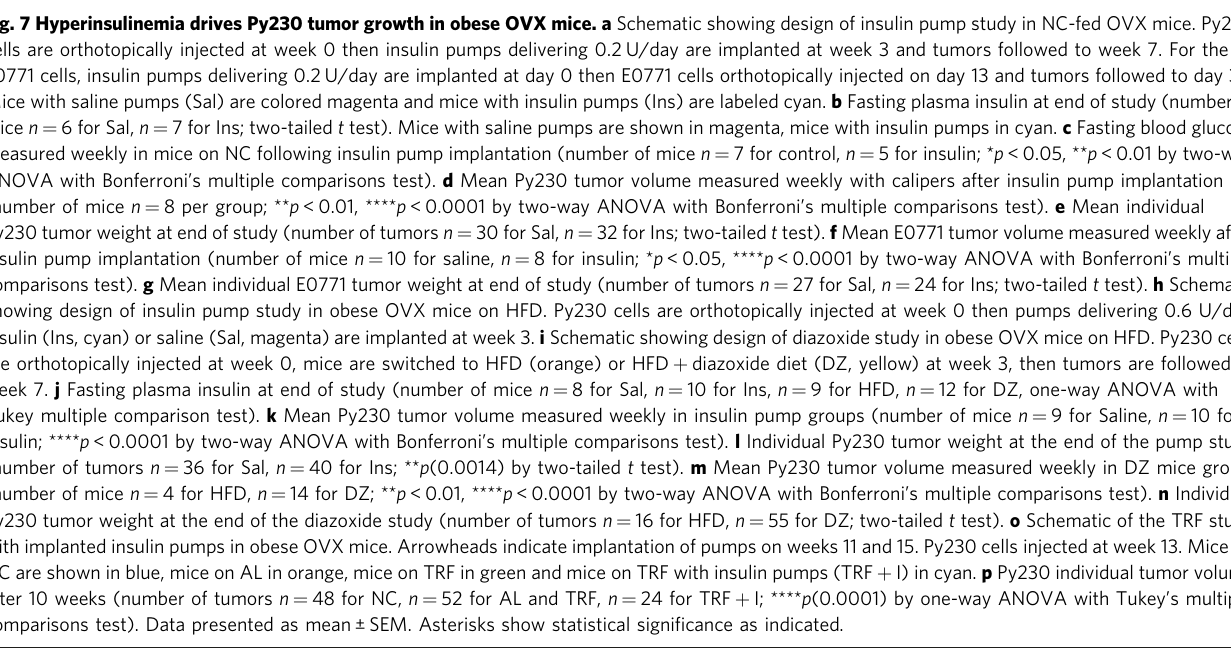
Fig. 7 Hyperinsulinemia drives Py230 tumor growth in obese OVX mice. a Schematic showing design of insulin pump study in NC-fed OVX mice. Py230 cells are orthotopically injected at week 0 then insulin pumps delivering 0.2 U/day are implanted at week 3 and tumors followed to week 7. For the E0771 cells, insulin pumps delivering 0.2 U/day are implanted at day 0 then E0771 cells orthotopically injected on day 13 and tumors followed to day 35. Mice with saline pumps (Sal) are colored magenta and mice with insulin pumps (Ins) are labeled cyan. b Fasting plasma insulin at end of study (number of mice n = 6 for Sal, n = 7 for Ins; two-tailed t test). Mice with saline pumps are shown in magenta, mice with insulin pumps in cyan. c Fasting blood glucose measured weekly in mice on NC following insulin pump implantation (number of mice n = 7 for control, n = 5 for insulin; * p < 0.05, ** p < 0.01 by two-way ANOVA with Bonferroni ’ s multiple comparisons test). d Mean Py230 tumor volume measured weekly with calipers after insulin pump implantation (number of mice n = 8 per group; ** p < 0.01, **** p < 0.0001 by two-way ANOVA with Bonferroni ’ s multiple comparisons test). e Mean individual Py230 tumor weight at end of study (number of tumors n = 30 for Sal, n = 32 for Ins; two-tailed t test). f Mean E0771 tumor volume measured weekly after insulin pump implantation (number of mice n = 10 for saline, n = 8 for insulin; * p < 0.05, **** p < 0.0001 by two-way ANOVA with Bonferroni ’ s multiple comparisons test). g Mean individual E0771 tumor weight at end of study (number of tumors n = 27 for Sal, n = 24 for Ins; two-tailed t test). h Schematic showing design of insulin pump study in obese OVX mice on HFD. Py230 cells are orthotopically injected at week 0 then pumps delivering 0.6 U/day insulin (Ins, cyan) or saline (Sal, magenta) are implanted at week 3. i Schematic showing design of diazoxide study in obese OVX mice on HFD. Py230 cells are orthotopically injected at week 0, mice are switched to HFD (orange) or HFD + diazoxide diet (DZ, yellow) at week 3, then tumors are followed to week 7. j Fasting plasma insulin at end of study (number of mice n = 8 for Sal, n = 10 for Ins, n = 9 for HFD, n = 12 for DZ, one-way ANOVA